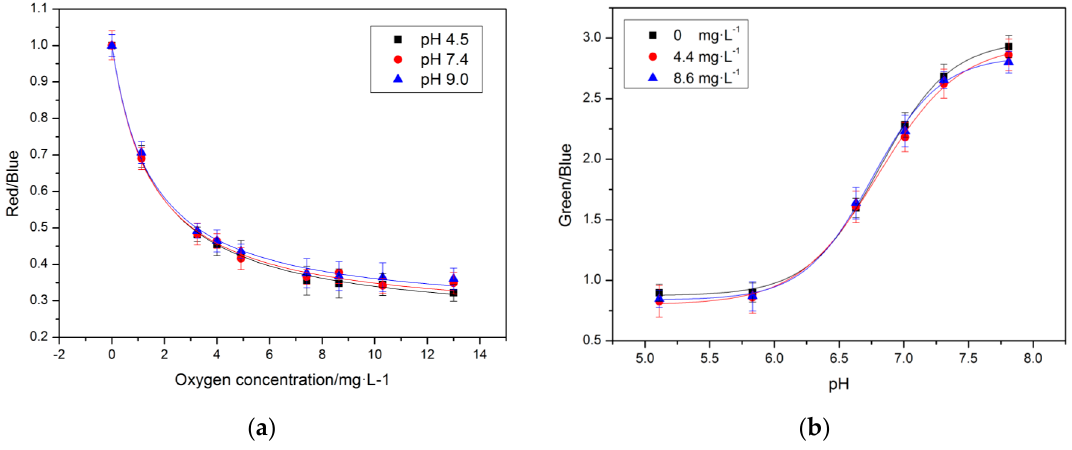
Figure 4. The calibration curves for ( a ) oxygen and pH ( b ) in seawater. (17.0 ± 0.2 °C).